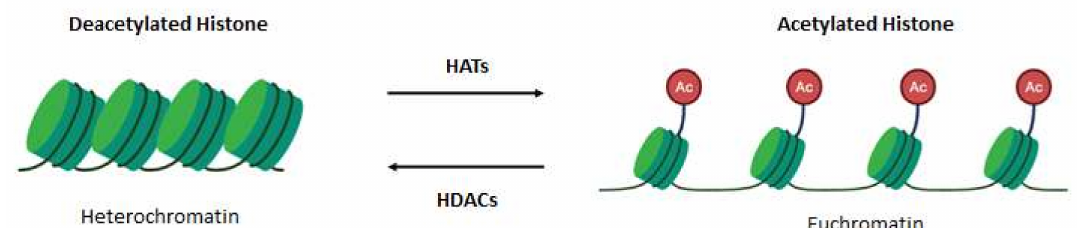
Figure 1. The process of histone acetylation and deacetylation. Histone acetylation is catalysed by histone acetyltrans- ferases (HATs) and is associated with a transcriptionally active chromatin structure (euchromatin). In contrast, histone deacetylation is mediated by histone deacetylases (HDACs) and is associated with a transcriptionally repressed chromatin structure